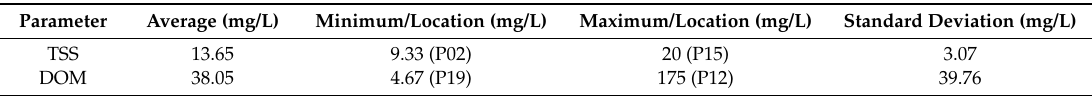
Table 1. Results of TSS and DOM analysis.